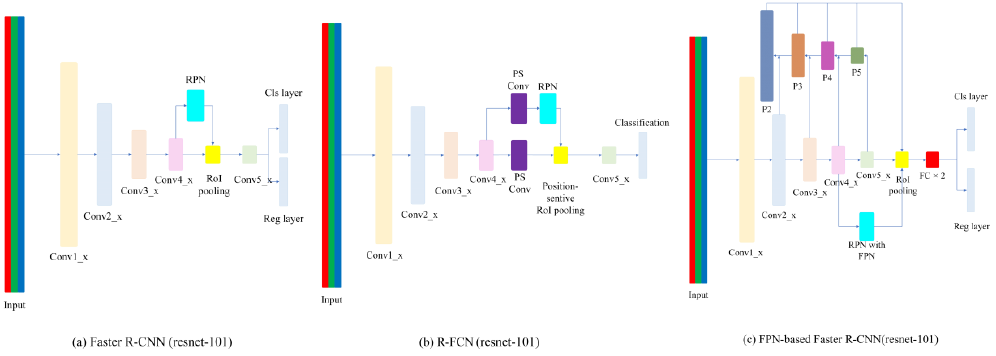
Figure 3. Overall architecture of the three region-based detection frameworks under consideration.